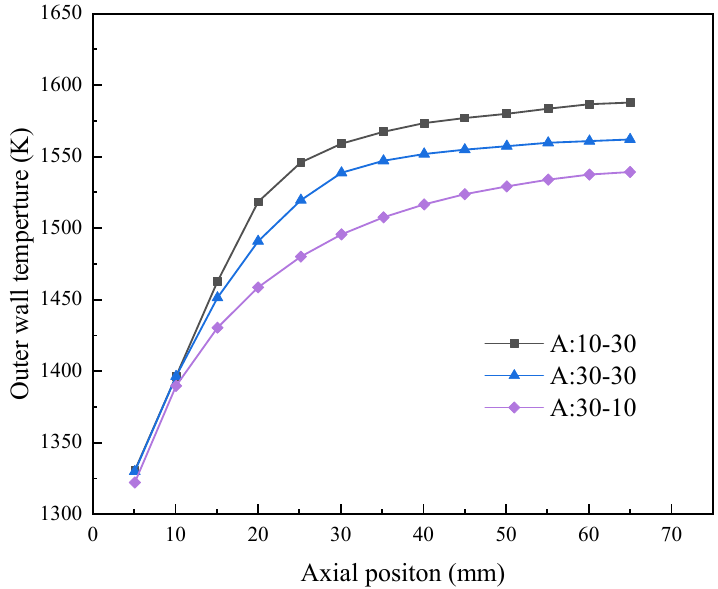
Figure 6. Wall temperature of three different PM layouts.